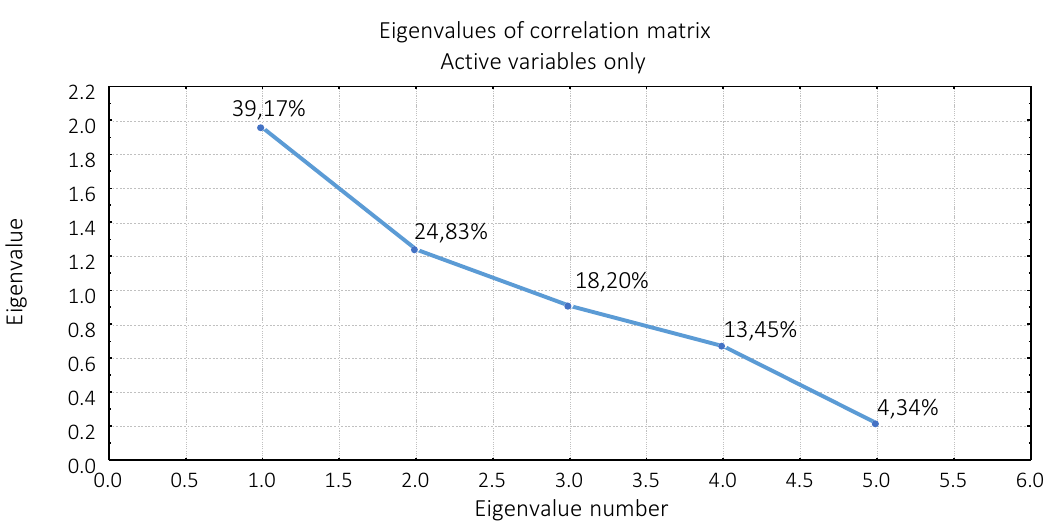
Figure 1. Determining the contribution of each of five components of economic security using the scree plot